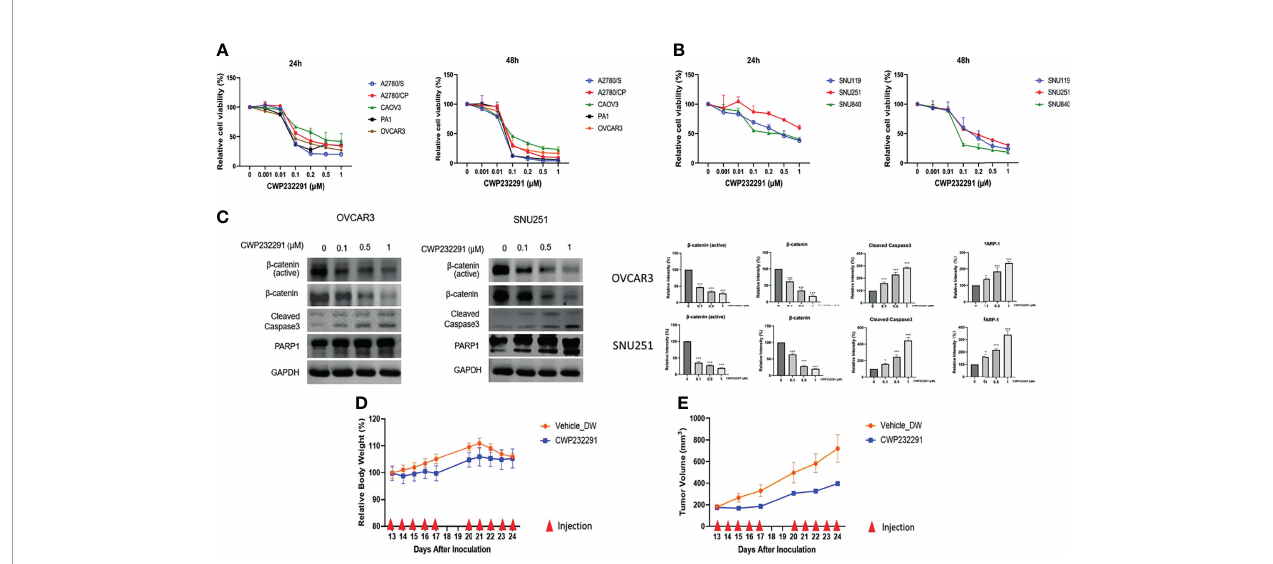
expression of the total form and active form of b -catenin (a non- phosphorylated form of b -Catenin when residues Ser33, Ser37,